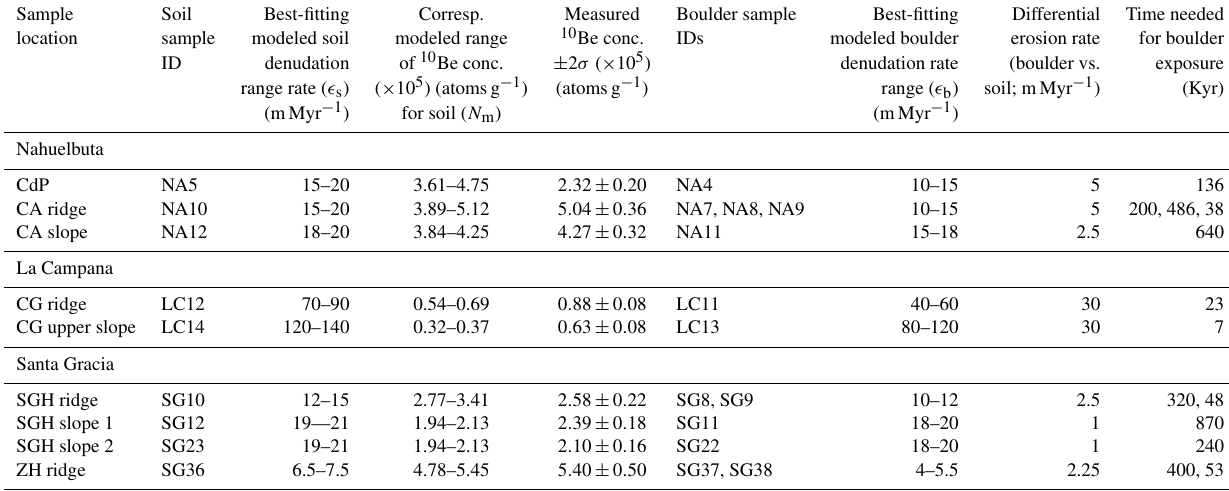
Table 2. Modeled denudation rates for soil and boulder samples using the first term of Eq. (1) and comparison of modeled and measured 10 Be concentrations for soil samples. Sample location abbreviations are described in the caption to Table 1.